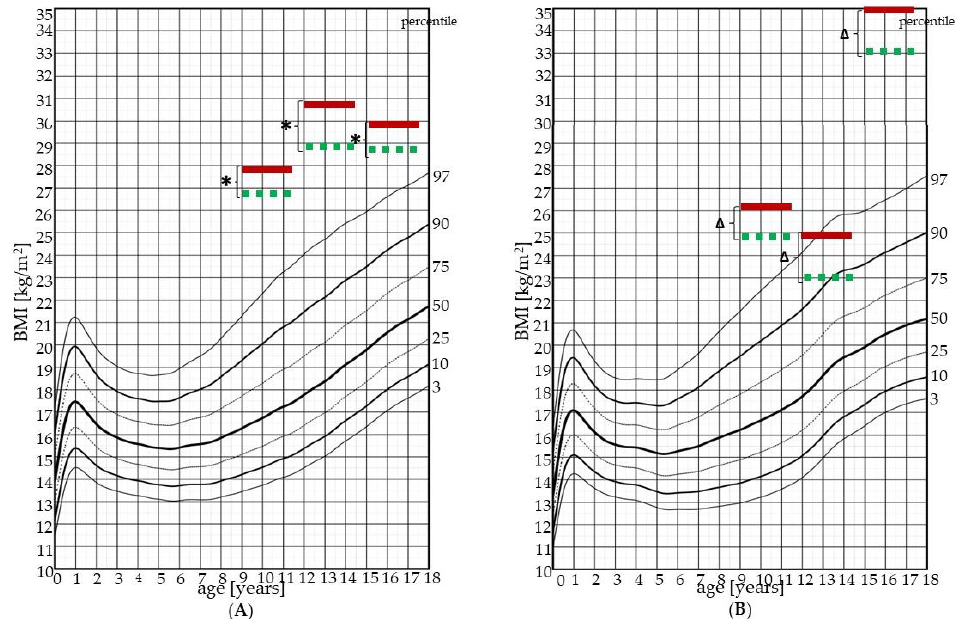
Figure 3. Body mass index (BMI) in measurements I. and II. for males ( A ) and females ( B ). Solid red line represents measurement I., made at the beginning of the one-month stay in the children’s hospital, dashed green line represents measurement II., made at the end of the one-month stay in the children’s hospital. *— p value is less than 0.01; Δ— p value is less than 0.05; p value—statistical evaluation of the differences between the measurements I. and II., Wilcoxon signed-rank test (paired test).